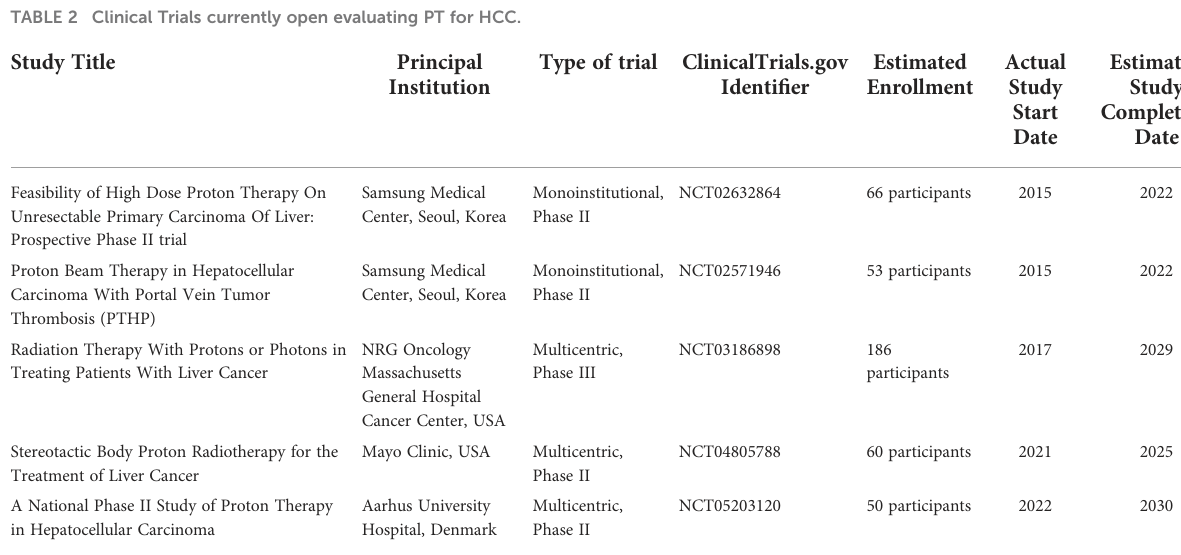
TABLE 2 Clinical Trials currently open evaluating PT for